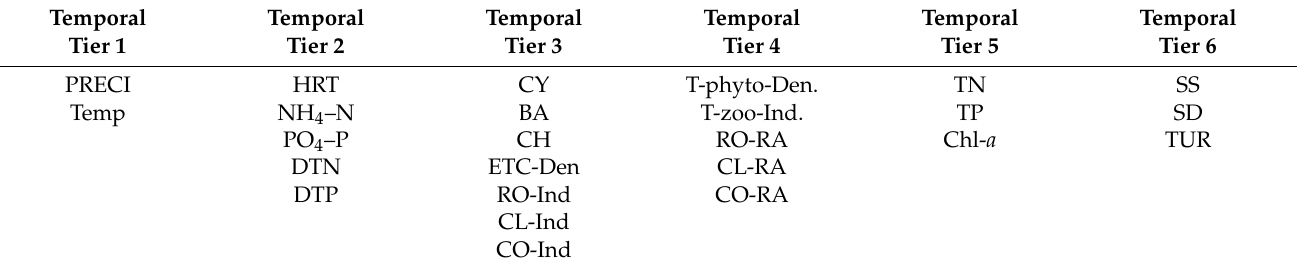
Table 1. Temporal tier components of the Bayesian search